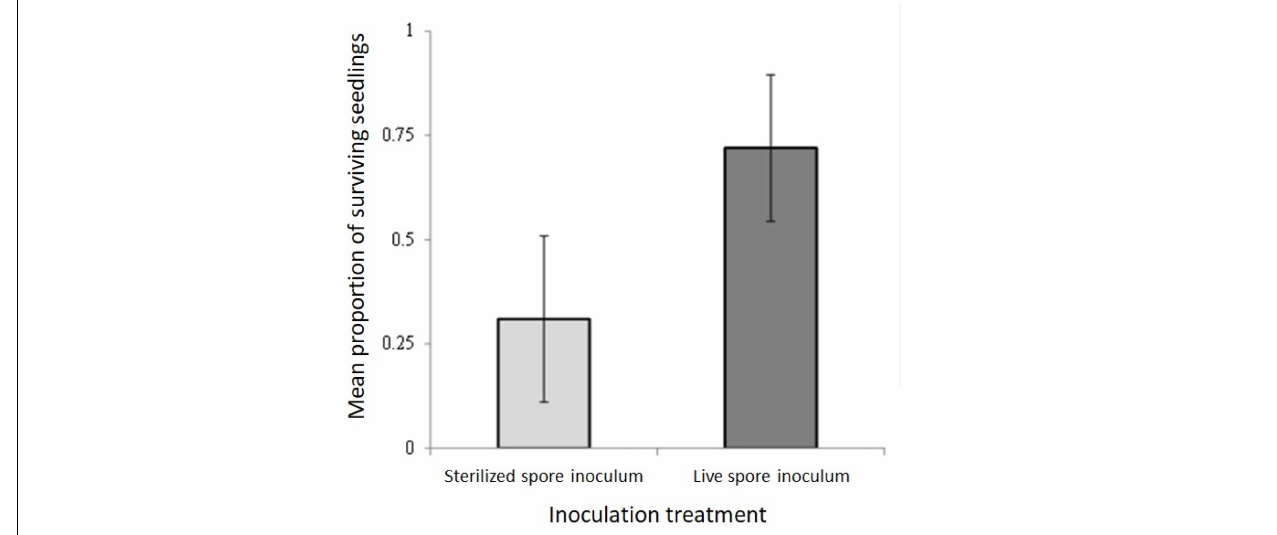
FIGURE B2 | Proportion of Pinus rigida seedlings that survived in the field inoculated with sterilized spore inoculum (light grey bar) and live spore inoculum (dark grey bar) of Suillus brevipes and Rhizopogon pseudoroseolus . Error bars show confidence intervals